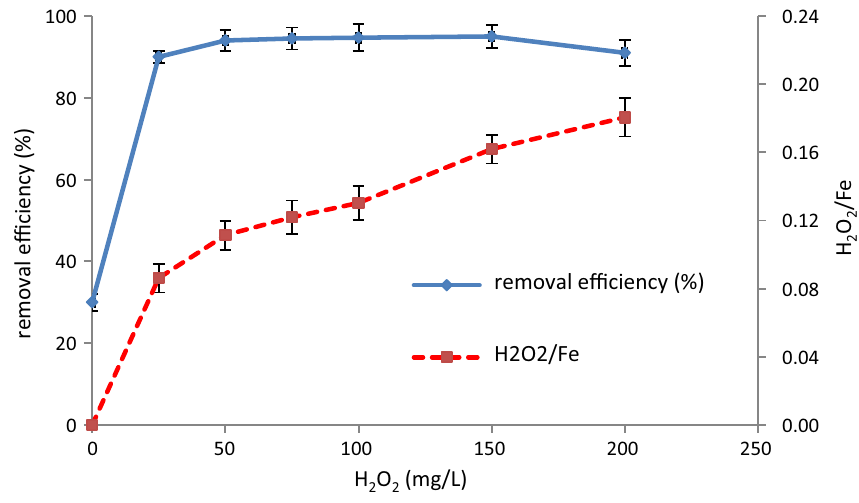
Fig. 6 Effect of H 2 O 2 dosage (0–200 mg/L) on MG deg- radation in EFP (initial MG concentration = 200 mg/L; solu- tion pH = inherent (3); current density = 10 mA/cm2; reaction time = 10 min)